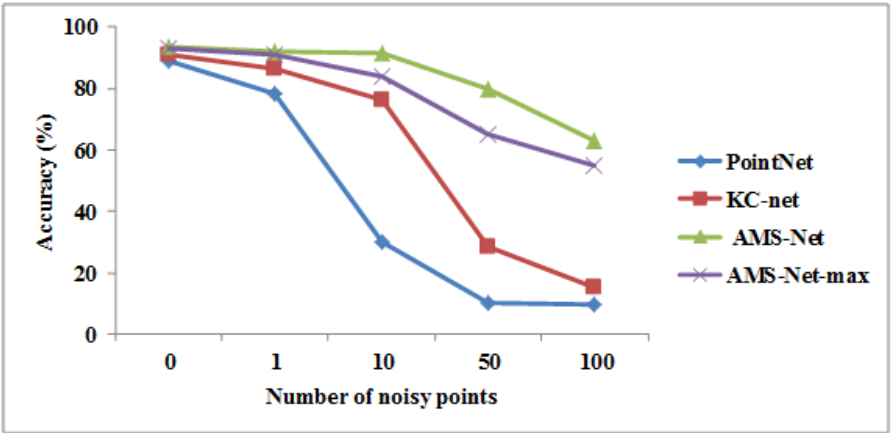
Figure 10. Test results of robustness. ( a ) Point cloud with random point dropout; ( b ) Our AMS-Net results with sparser points of ( a ) as the input, and our model is trained with 1024 points. To further verify the ability to deal with noise, we do the experiment like PointNet [24] and KC-Net [28] on random noise in the input point cloud. To achieve fair comparisons, the same training set and test set are the same with KC-Net, which replaces a certain number of randomly selected points with random noise ranging ( − 1.0, 1.0) during testing. The comparisons with PointNet and KC-Net are shown in Figure 11. The accuracy of PointNet drops 58.6% when 10 points are replaced with random noise, and KC-Net drops 23.8%, while our AMS-Net only drops 4.08% (from 93.52% to 91.6%). As shown in Figure 11, our AMS-Net is relatively robust to noise. The decrease in accuracy becomes larger when AAS is replaced with max-pooling in the LFA-Cell.